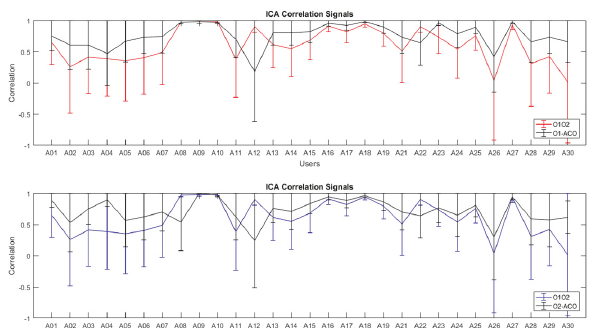
Figure 33: Comparative result of the original signals versus signals with ant colony